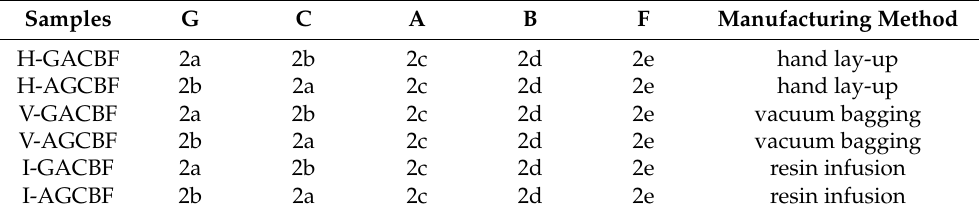
Table 1. Sample assignment including laminate stacking sequences and manufacturing